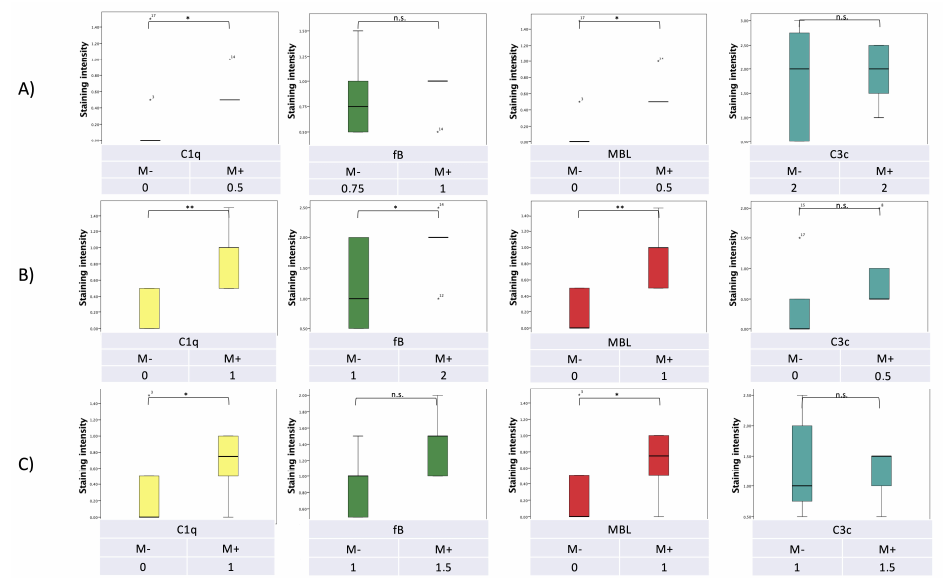
Figure 5. Semi-quantitative expression of complement factors ( A ) in the lesional stroma, ( B ) in the lesional epithelium, and ( C ) in the lesional inflammatory cells related to the presence (M+) or absence (M − ) Malassezia DNA (* p < 0.05; ** p < 0.005; n.s. not